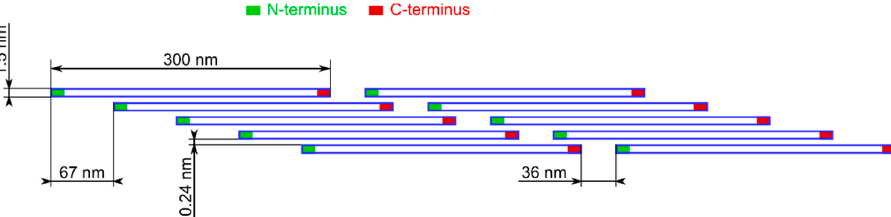
Figure 1. Arrangement of collagen in the microfibril. The diameters of the proteins and the 0.24 nm spaces between the molecules are disproportionately large for the illustration.